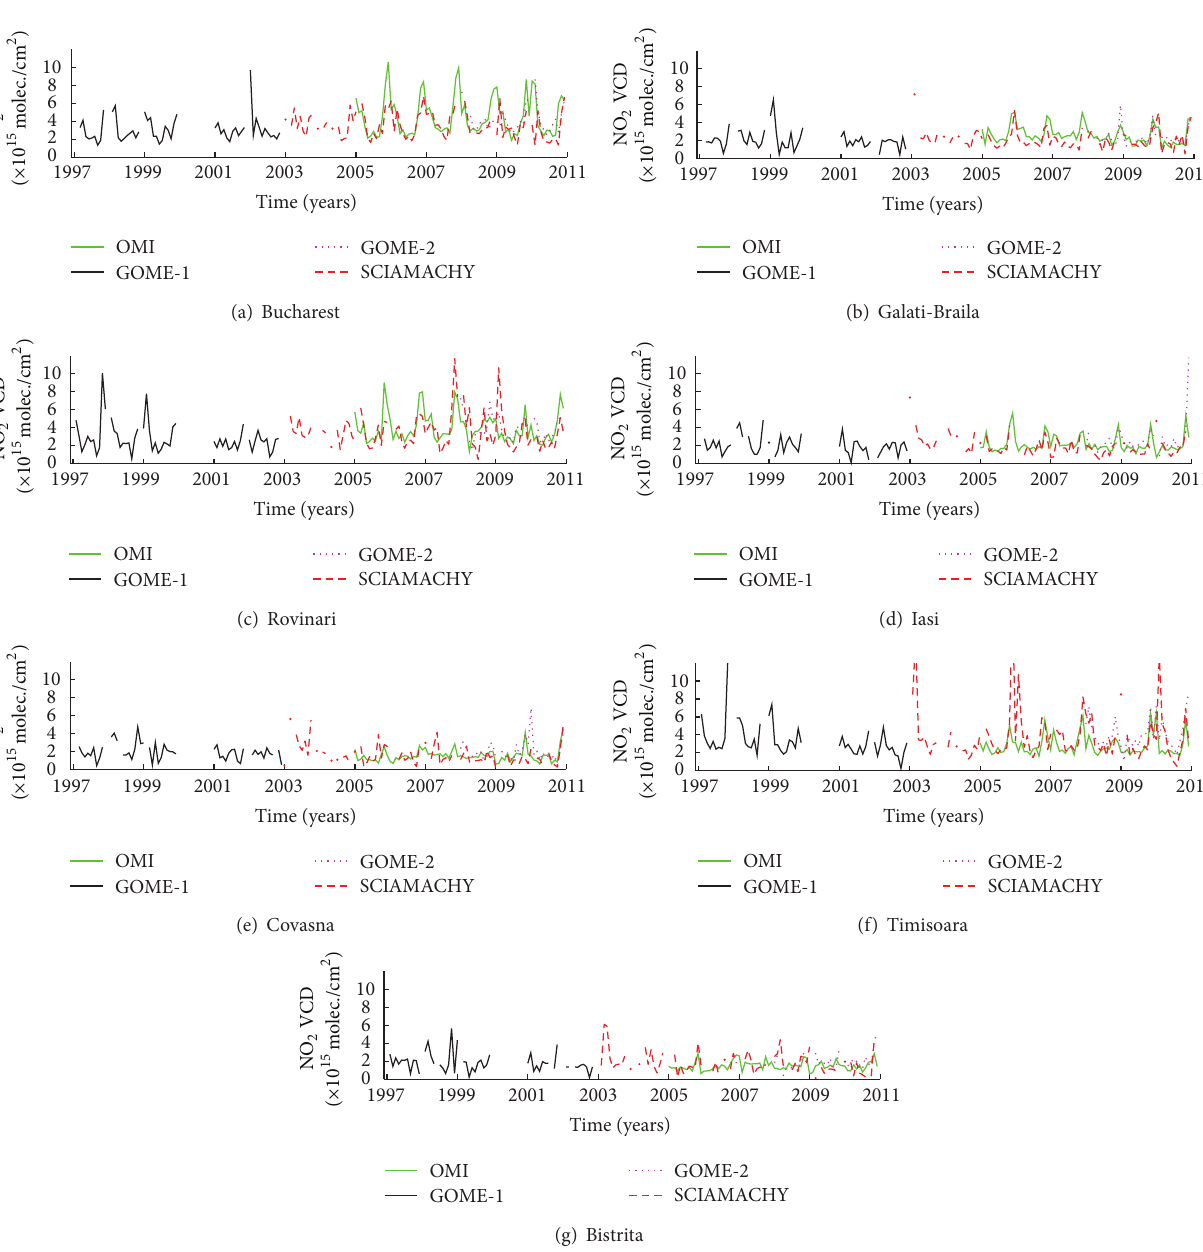
Figure 3: Time series of NO 2 loading for all cities, for the entire period when satellite observation is available (1997–2010), using data from GOME, SCIAMACHY, OMI, and